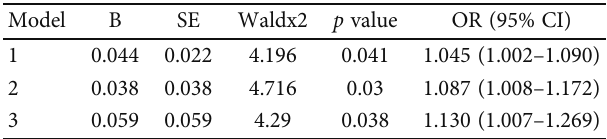
Figure 2: Correlation analysis of gut bacterial genera with blood glucose levels and HbA1c. HbA1c: glycosylated hemoglobin; FBG: fasting blood glucose; 2hPG: 2-hour plasma glucose. Table 4: Logistic regression analysis of the e ff ect of the Bacteroides genus on